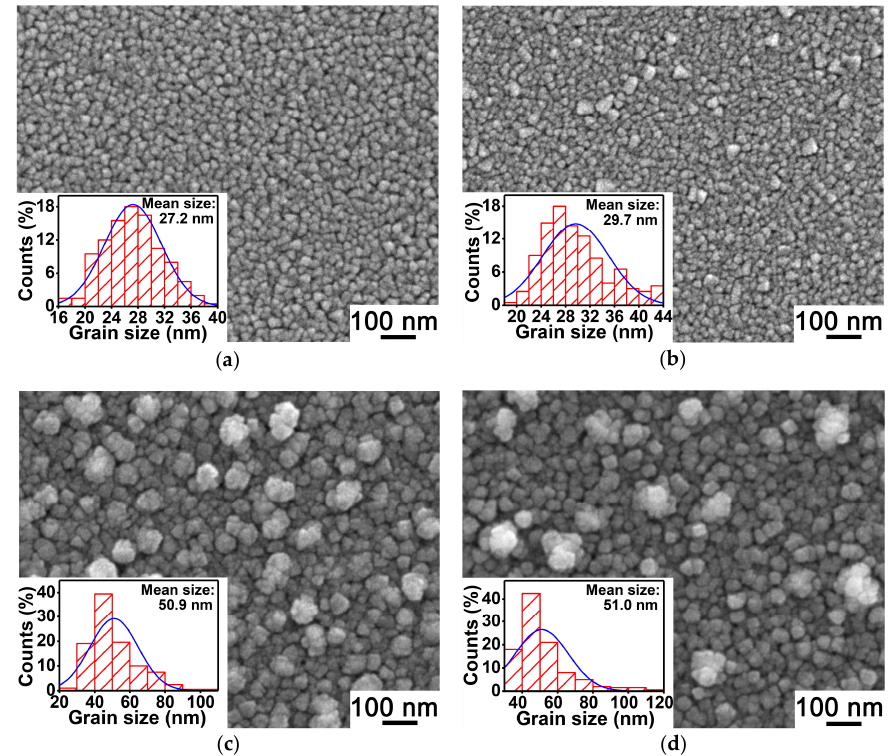
Figure 3. SEM micrographs and MgO grain size probability histograms of ( a ) an undoped MgO film sample and three Au-doped MgO film samples with doping concentrations of ( b ) 1.5%, ( c ) 3.0%, and ( d ) 4.5%.